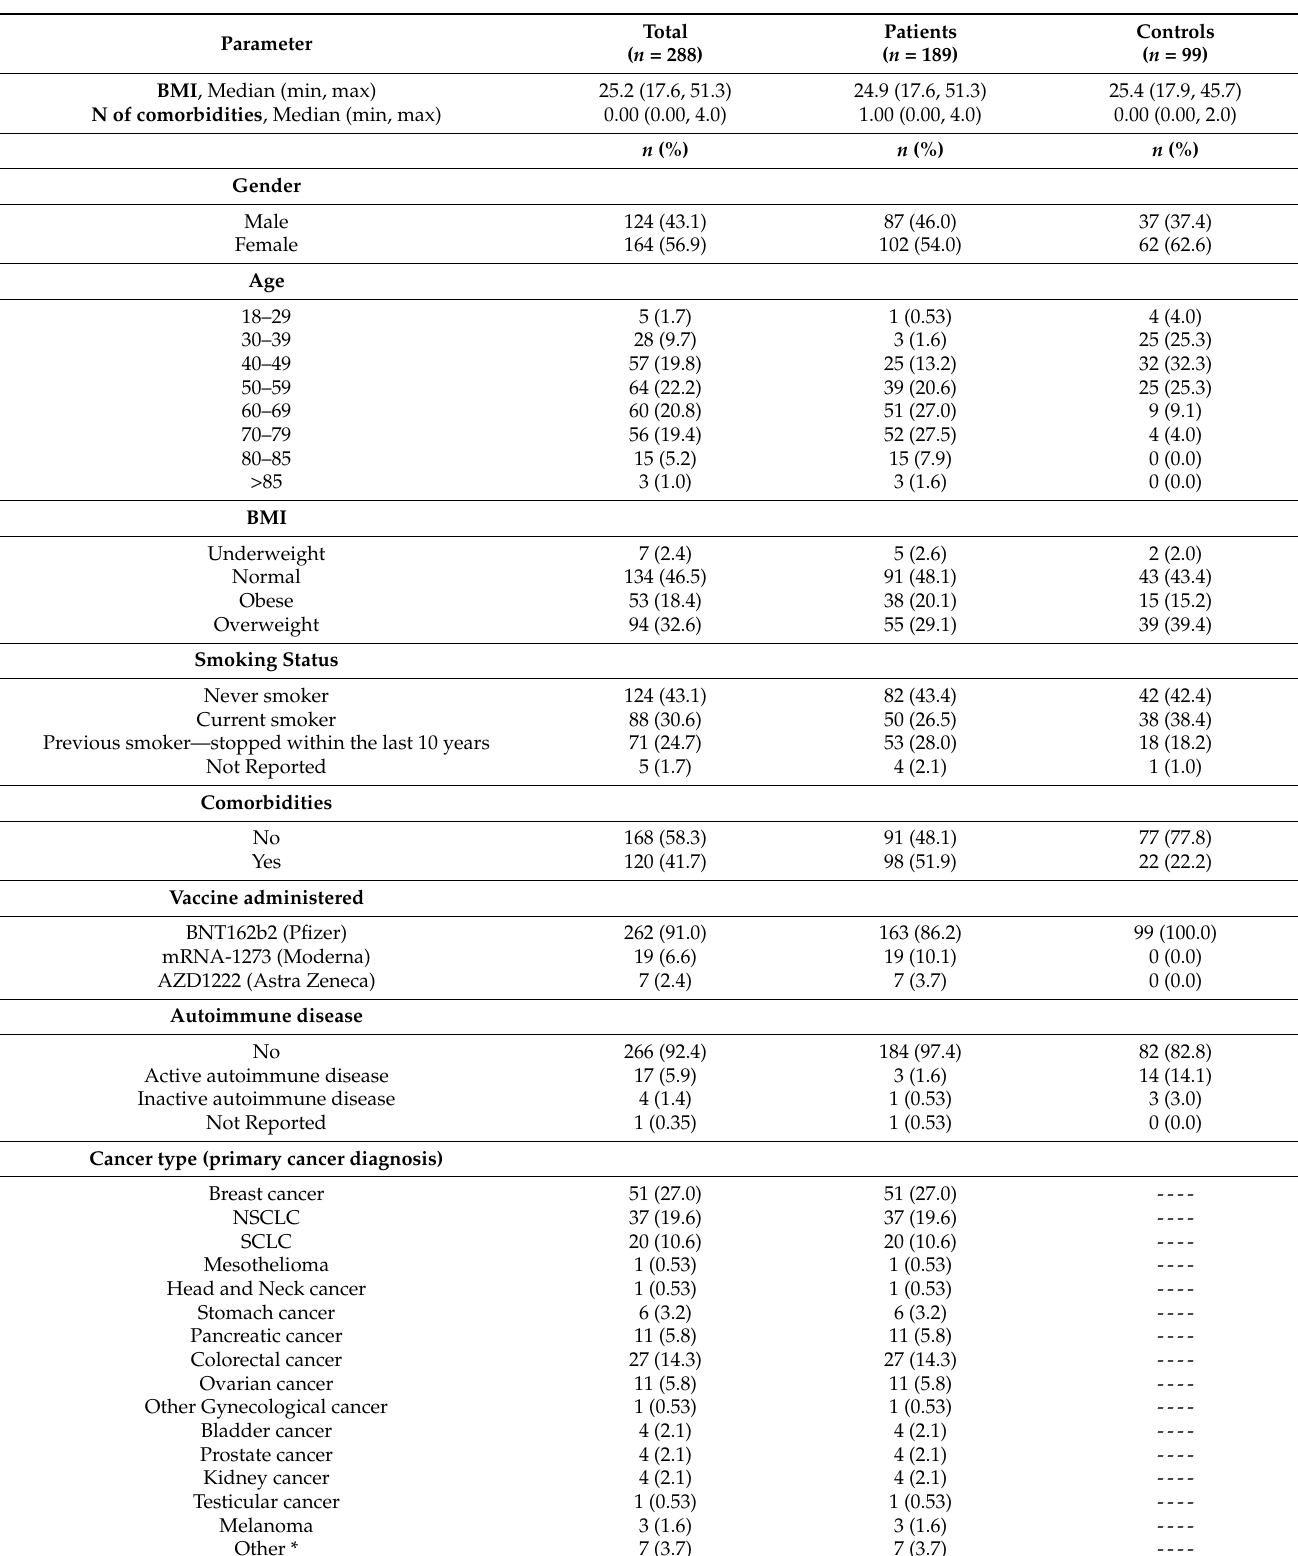
Table 1. Baseline characteristics for patients and